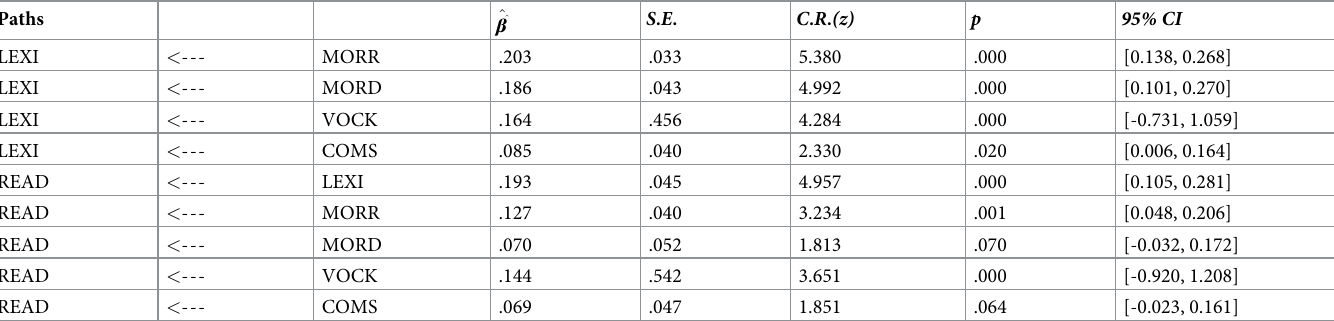
Table 4. Standardized regression weights for the preferred path model.